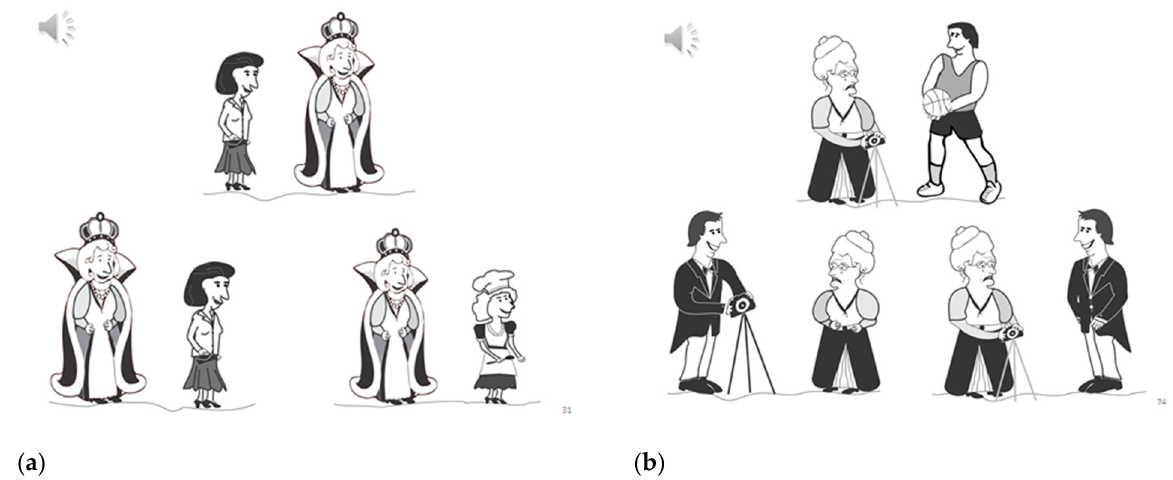
Figure 2. ( a ): OBJ RC, gender match (9a), ( b ): OBJ RC, gender mismatch (9b).